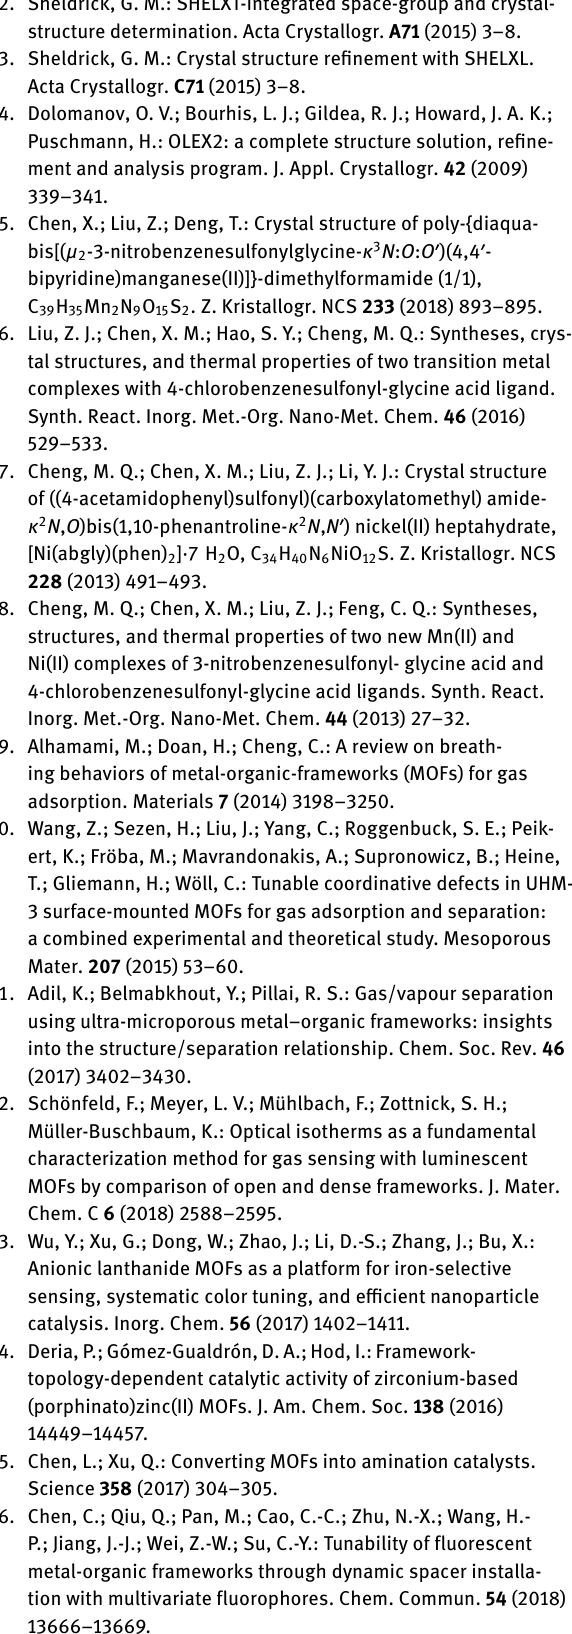
Table 2: Fractional atomic coordinates and isotropic or equivalent isotropic displacement parameters (Å 2